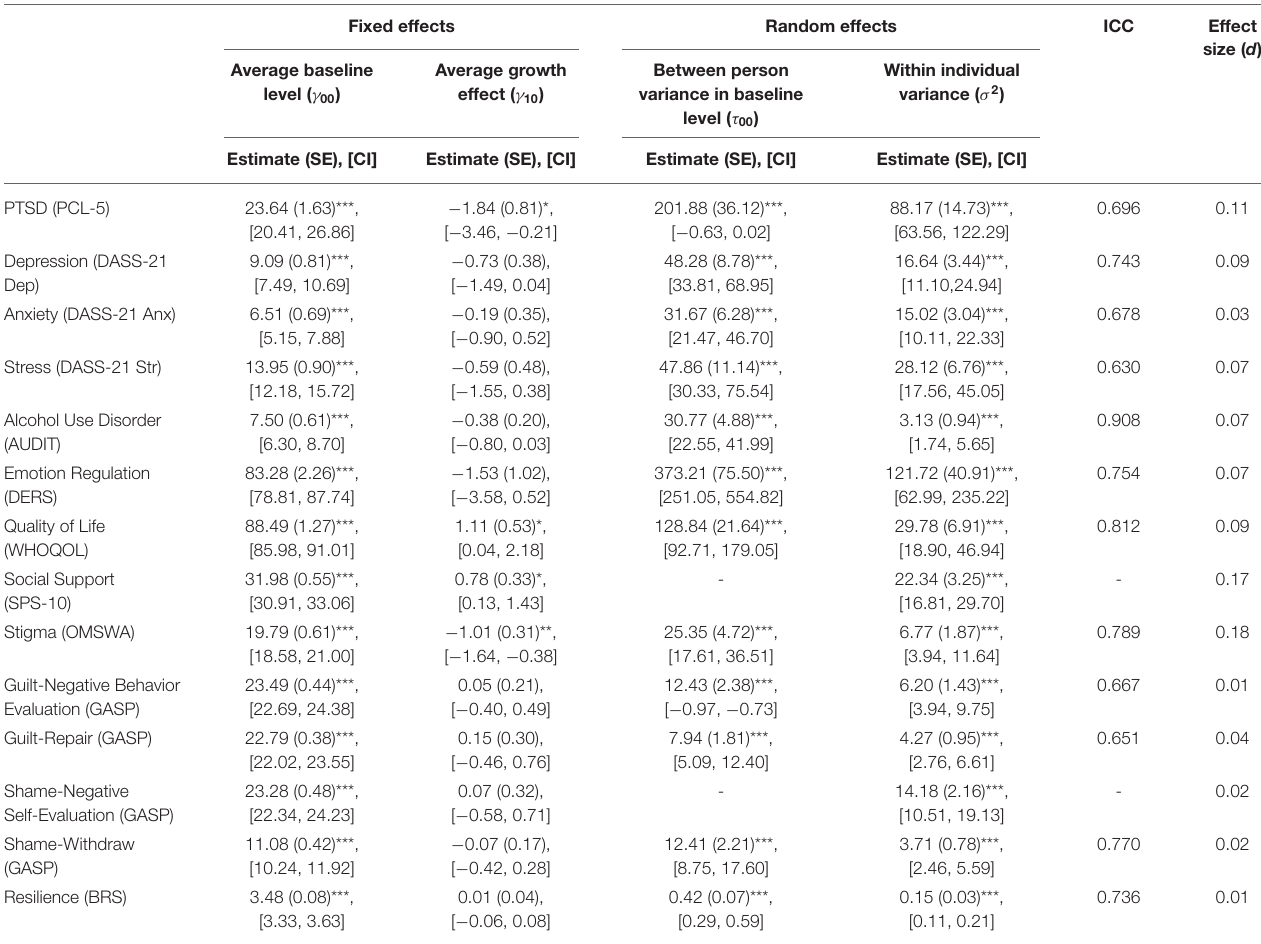
TABLE 3 | Two-level mixed model estimates for outcome